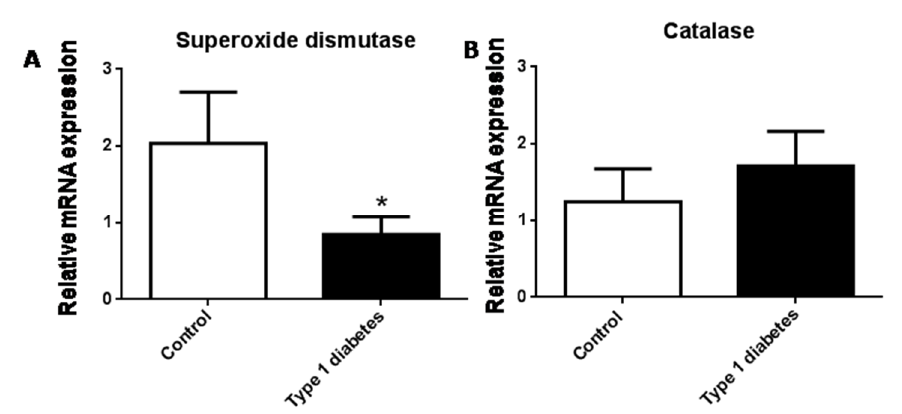
Figure 4. Evaluation of mRNA expression of SOD ( A ) and CAT ( B ) in type 1 diabetic and control subjects. Data are expressed as mean ± SEM. * p < 0.05, control vs. type 1 diabetic subjects. * p < 0.05 control vs. type 1 diabetic subjects.